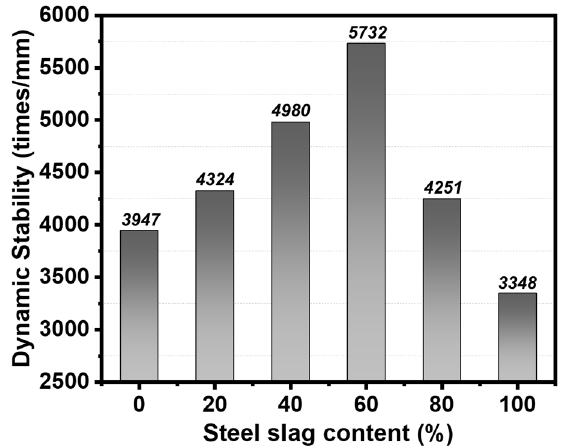
Figure 6. High temperature performance of different steel slag contents.